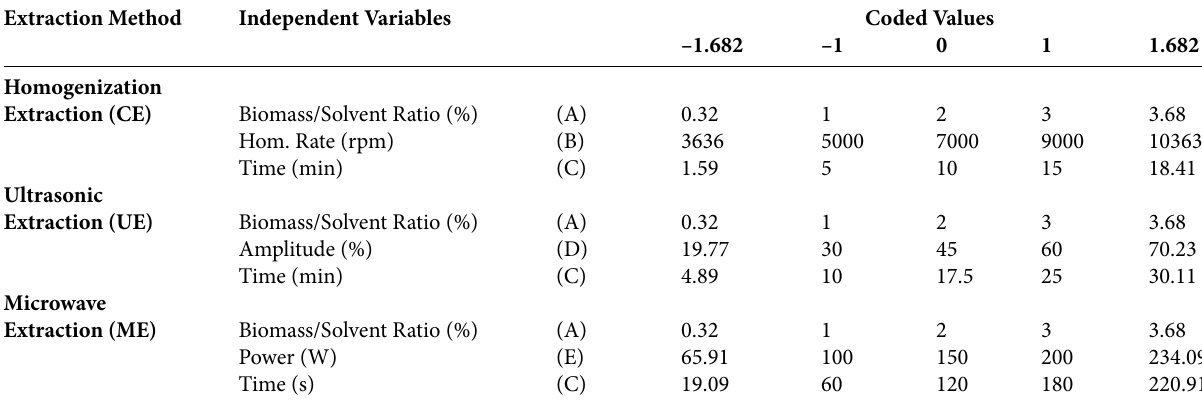
Table 1. Extraction process variables and levels for the specific CCRD experimental design Extraction Method Independent